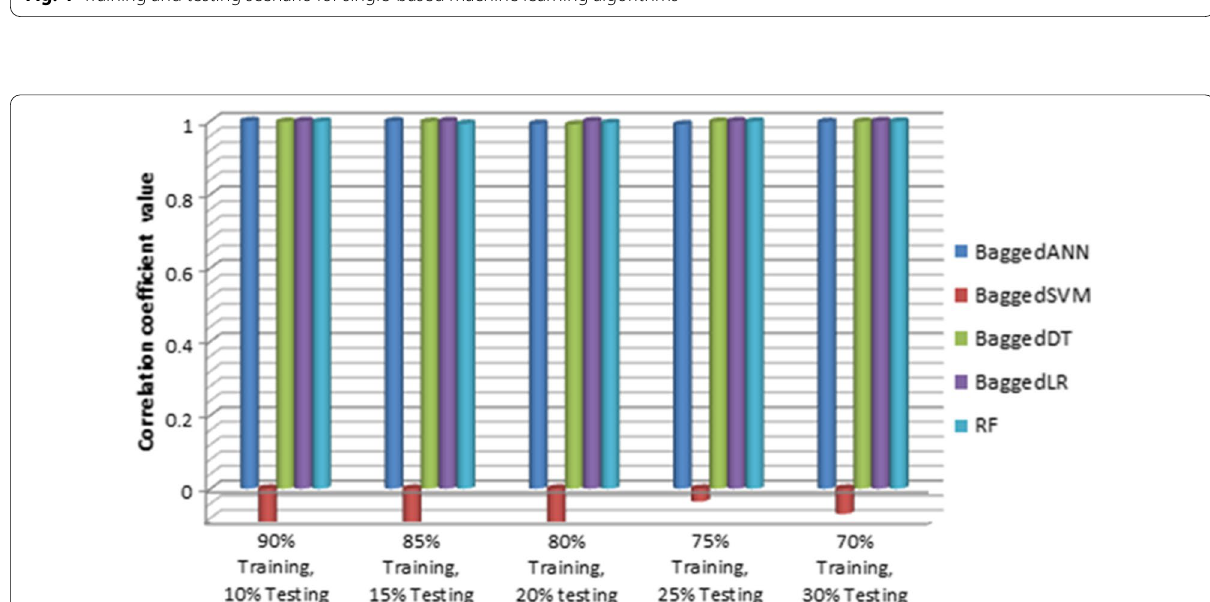
Fig. 5 Training and testing scenarios for bagging ensemble approach